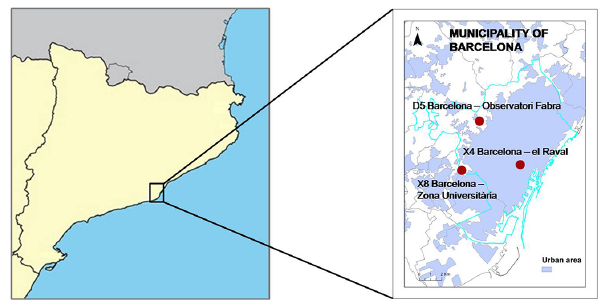
Figure 4. Location of the three SMC automatic rain gauges in Barcelona.